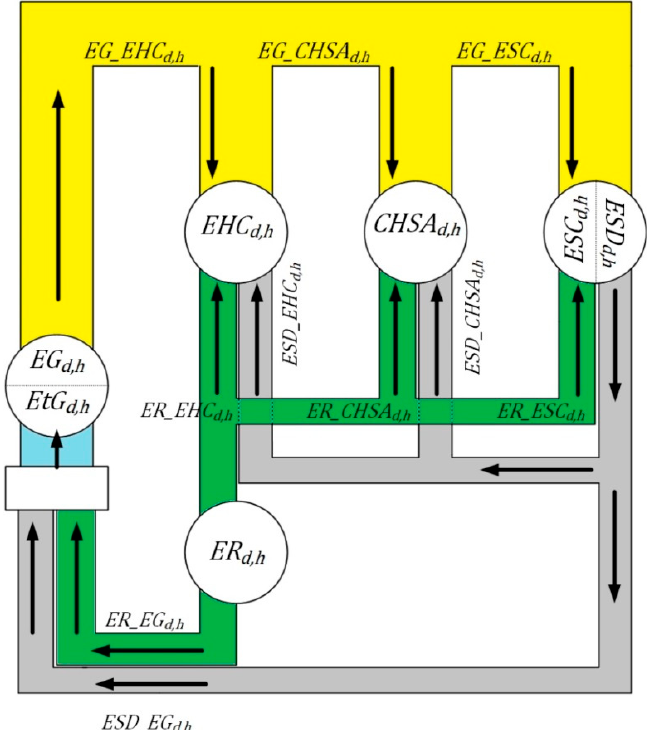
Figure 3. Representation of the physical model of a microgrid for a single prosumer. Source: self- elaboration.